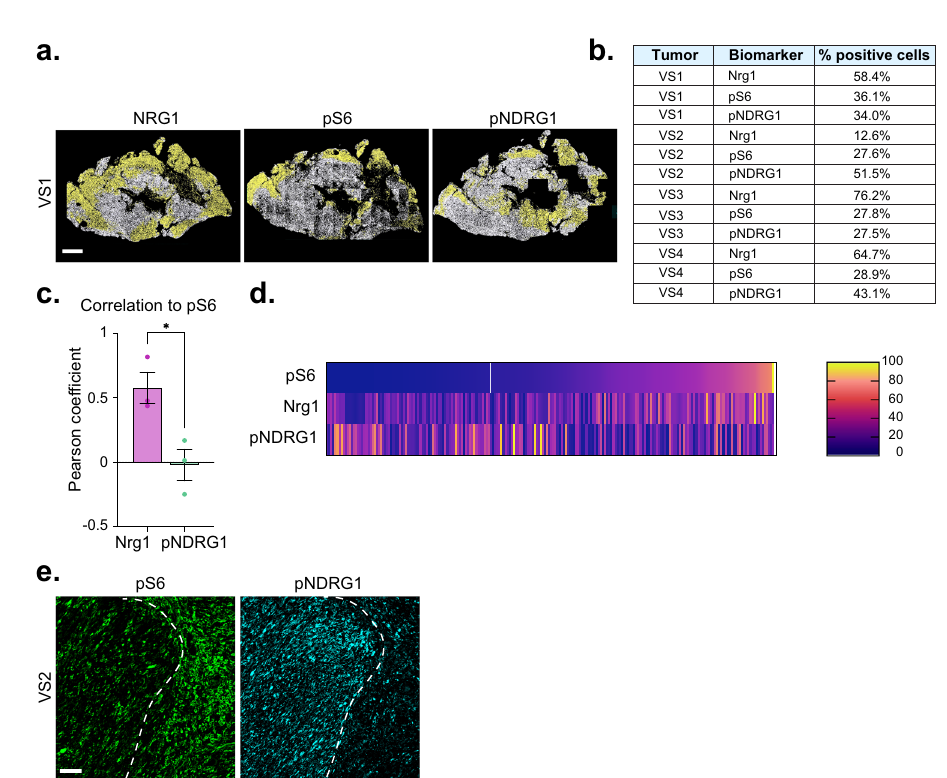
Fig. 7 | Quantitative analysis of self-generated heterogeneity in human schwannoma tissue. a Segmentation analysis of NRG1, pS6, or pNDRG1 staining across entire serial sections of a representative human vestibular schwannoma (VS1).Scale bar, 1mm. b HALO-mediated quantitation ofpercentage of NRG1, pS6, or pNDRG1-positive cells across entire tumor sections of four different human vestibular schwannomas (VS1, 2, 3, 4). c Summary of correlation analysis of NRG1+ and pNDRG1+ cells with pS6 as measured by Pearson correlation coef fi cient. Bars